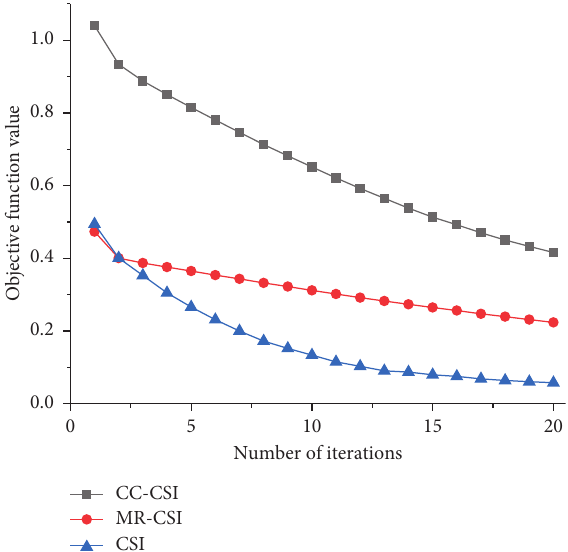
Figure 5: The objective function values of two scatterers (asymmetric).